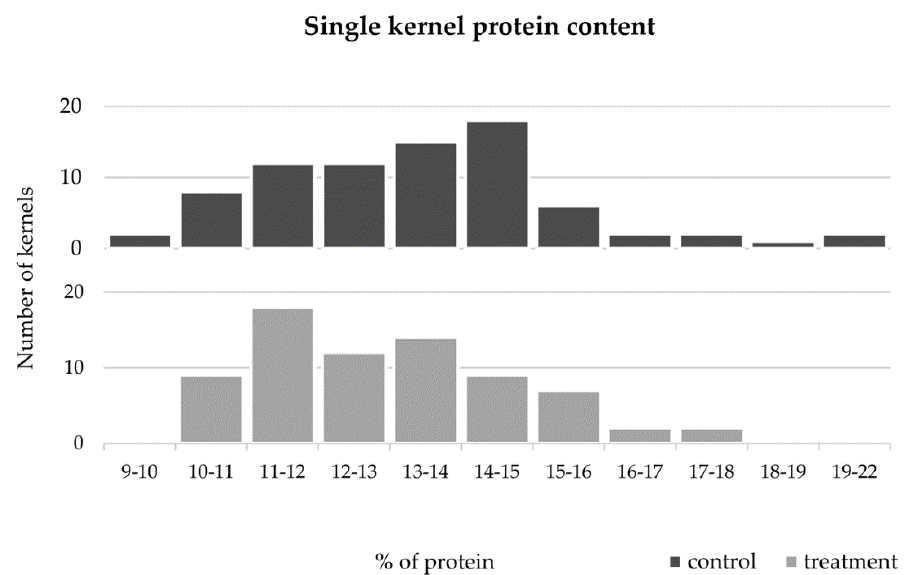
Figure 6. Distribution of single grains protein content from untreated (black) and high temperature treated (light gray) plants.